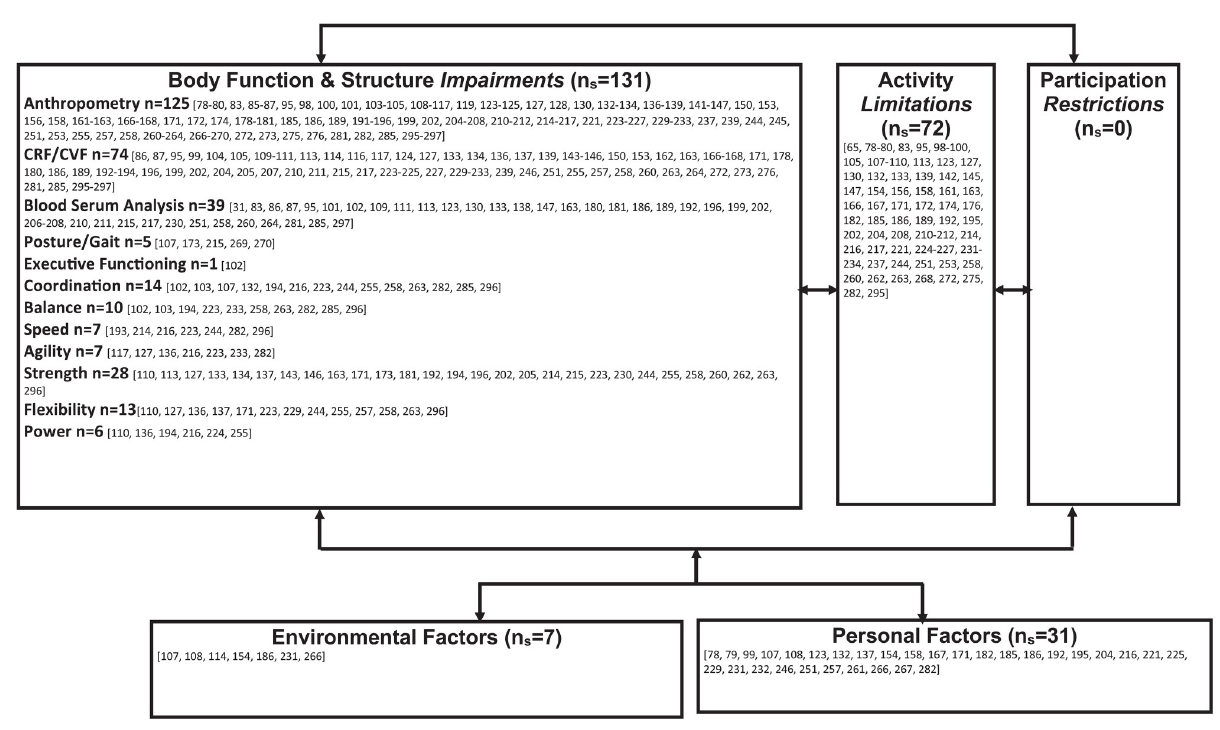
Fig 4. ICF-CY model with mapped outcome